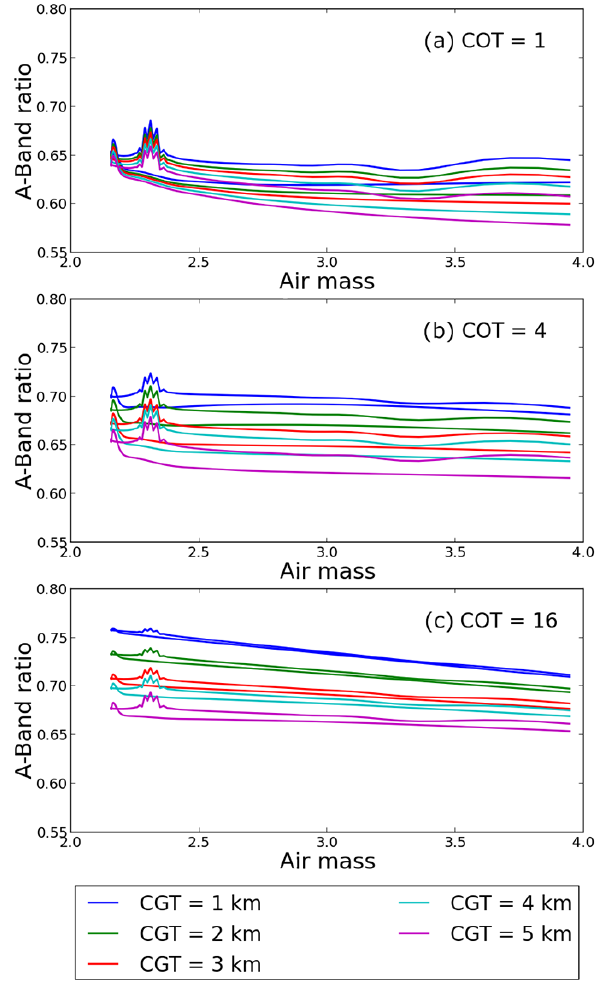
Figure 7. Same as Fig. 4 with a surface albedo of 0.2. (a) COT = 1, (b) COT = 4, (c) COT = 16.